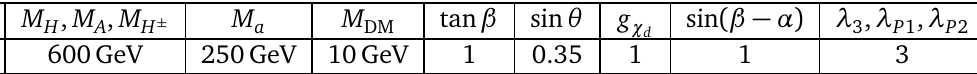
Table 1: Default parameter settings used in the 2HDM + a model. The masses of all the exotic Higgs bosons are indicated as M , M , M , the mass of the DM candidate A H H ± is M , the coupling of the pseudoscalar mediator a to DM is g χ , θ is the mixing DM d between the two neutral CP-odd weak eigenstates, and sin ( β − α ) is the sine of the difference of the mixing angles in the scalar potential containing only the Higgs dou- blets. Finally, λ are the quartic couplings of the Higgs i